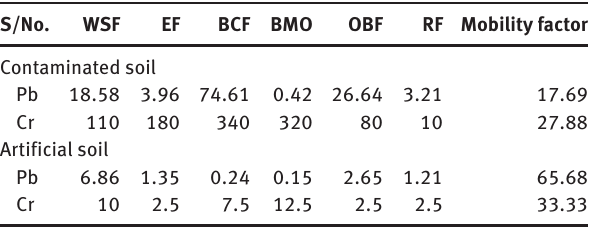
Table 2: Concentration of soil (Pb and Cr) in individual sequential extraction fraction in mg·kg -1 .